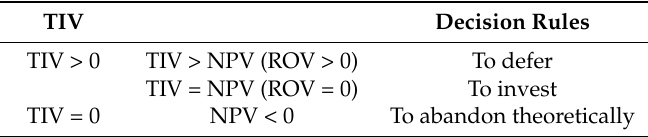
Table 1. The investment decision rules under